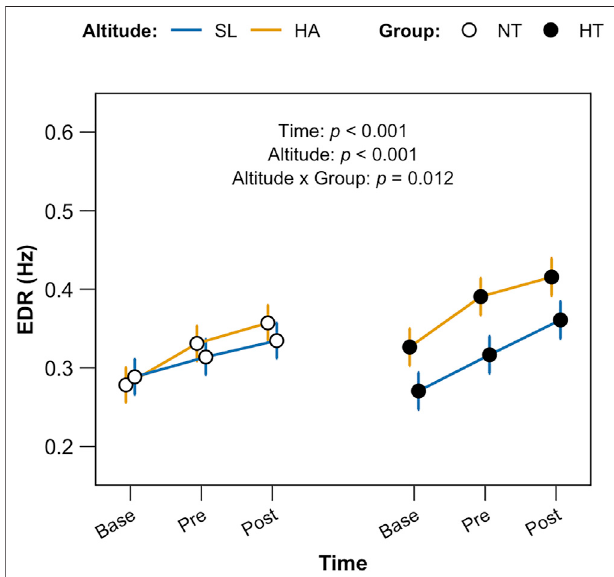
FIGURE 6 | ECG — derived respiration (EDR) data. Data are displayed per each time point (baseline, morning upon awakening, supine; pre, before 6MWT sitting; post, after 6MWT, sitting) for both groups (NT and HT) at both altitudes(HAandSL).Factorstimeandaltitude p < 0.01;altitudexgroup p =